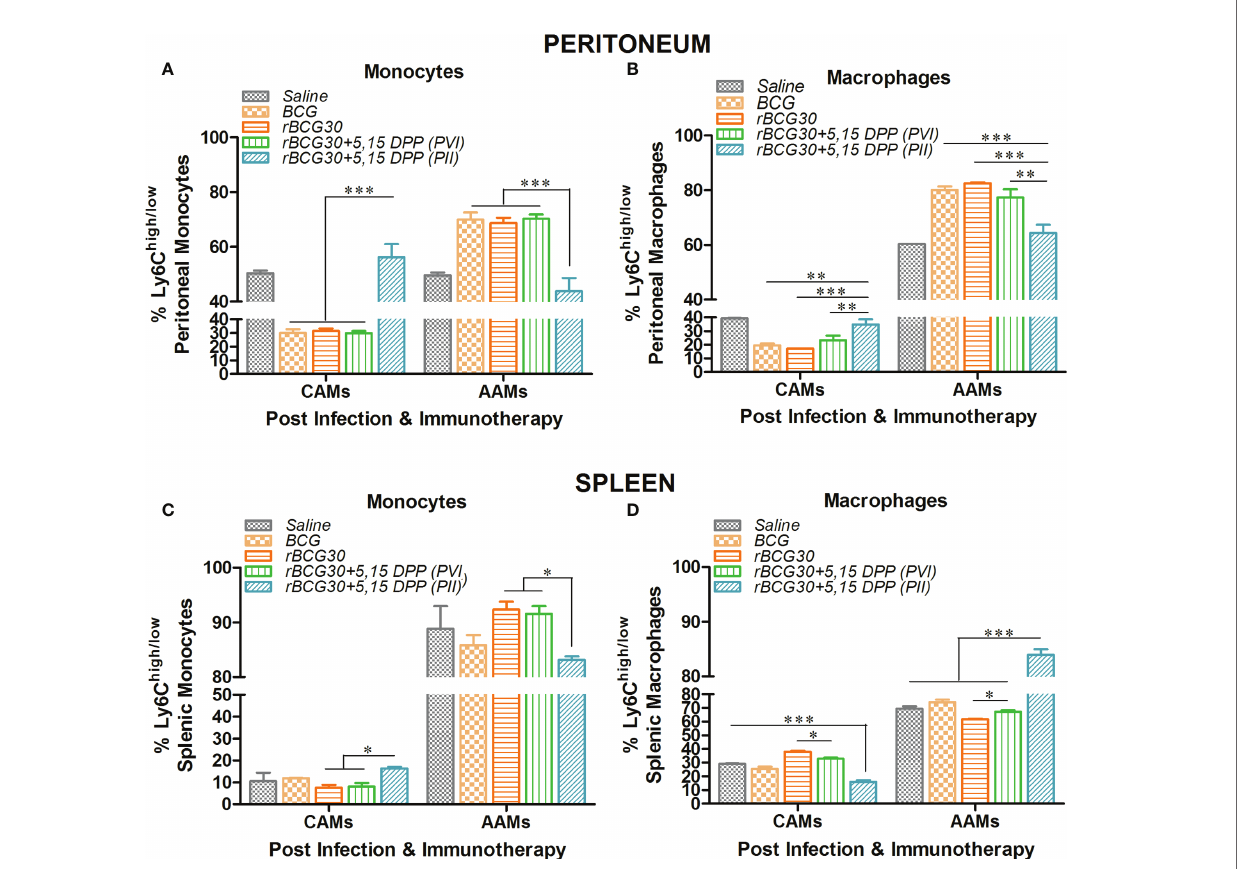
FIGURE 1 | The magnitude and phenotype of peritoneal and splenic monocyte/macrophage populations at 2 weeks post-challenge. Bar graphs in the fi gure represent percent numbers of Ly6C high CAMs and Ly6C low AAMs among (A, C) CD11b + F4/80 - SSC low monocytes, and (B, D) CD11b + F4/80 + SSC low macrophages. The cells were isolated from either peritoneum (upper panel) or spleen (lower panel) of the mice (n=3) belonging to various experimental groups the next day following completion of post-infection immunotherapy (PII) schedule (2 weeks PC with Mtb) and immunophenotyped employing fl ow cytometry. The results depicted in the fi gure are representative of two independent experiments and are presented as means ± SEM of one of the two experiments with similar observations. The statistical signi fi cance of the difference between various groups was performed by employing two-way ANOVA followed by Bonferroni ’ s multiple comparison post-test. The p values, <0.05(*), <0.01(**), <0.001(***) were considered as signi fi cant for analysis and interpretation of experimental